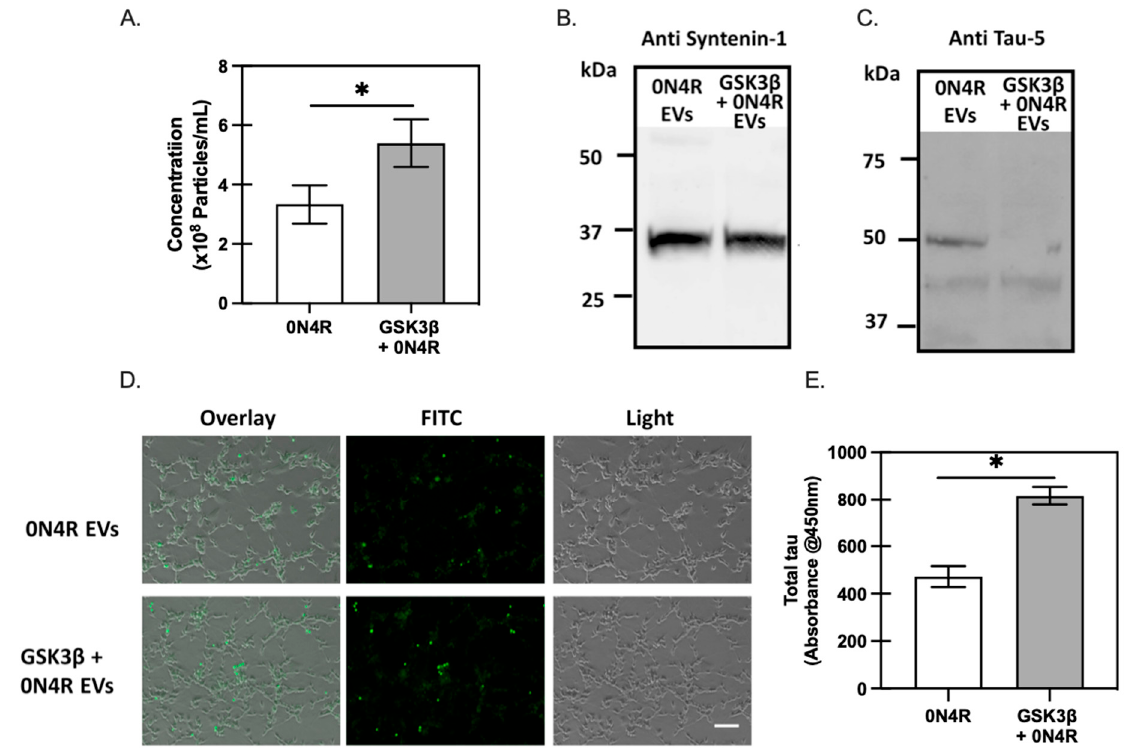
Figure 6. Tau inter-neuronal propagation is promoted by phosphorylation. Characterization of EVs isolated from HEK293TN cells transfected with the XPack™-0N4R construct (0N4R) without or with GSK3 β (GSK3 β + 0N4R) co-transfection. ( A ) ZetaView was used for measuring particle concentration (×10 8 particles/mL). The presence of exosomes was confirmed by immunoblotting isolated exosome lysates against the exosome biosynthesis marker, Syntenin-1 with a molecular weight of 34KDa ( B ). Immunoblotting exosome lysates against tau specific antibody Tau-5 ( C ) confirmed that tau protein was packaged into exosomes. ( D ) Mature neurons differentiated from SH-SY5Y cells were imaged under a fluorescent microscope after being treated with SYTO ® RNASelect TM Green Fluorescent Cell Stain (ThermoFisher, Waltham, MA, USA) labeled exosomes for 24 h at 37 °C. The scale bar denotes 100 µm. ( E ) Total human tau ELISA of recipient cell lysates shows more tau was taken up from EVs isolated from GSK3 β co-transfection (* represents p < 0.05 between two different groups, n = 2).